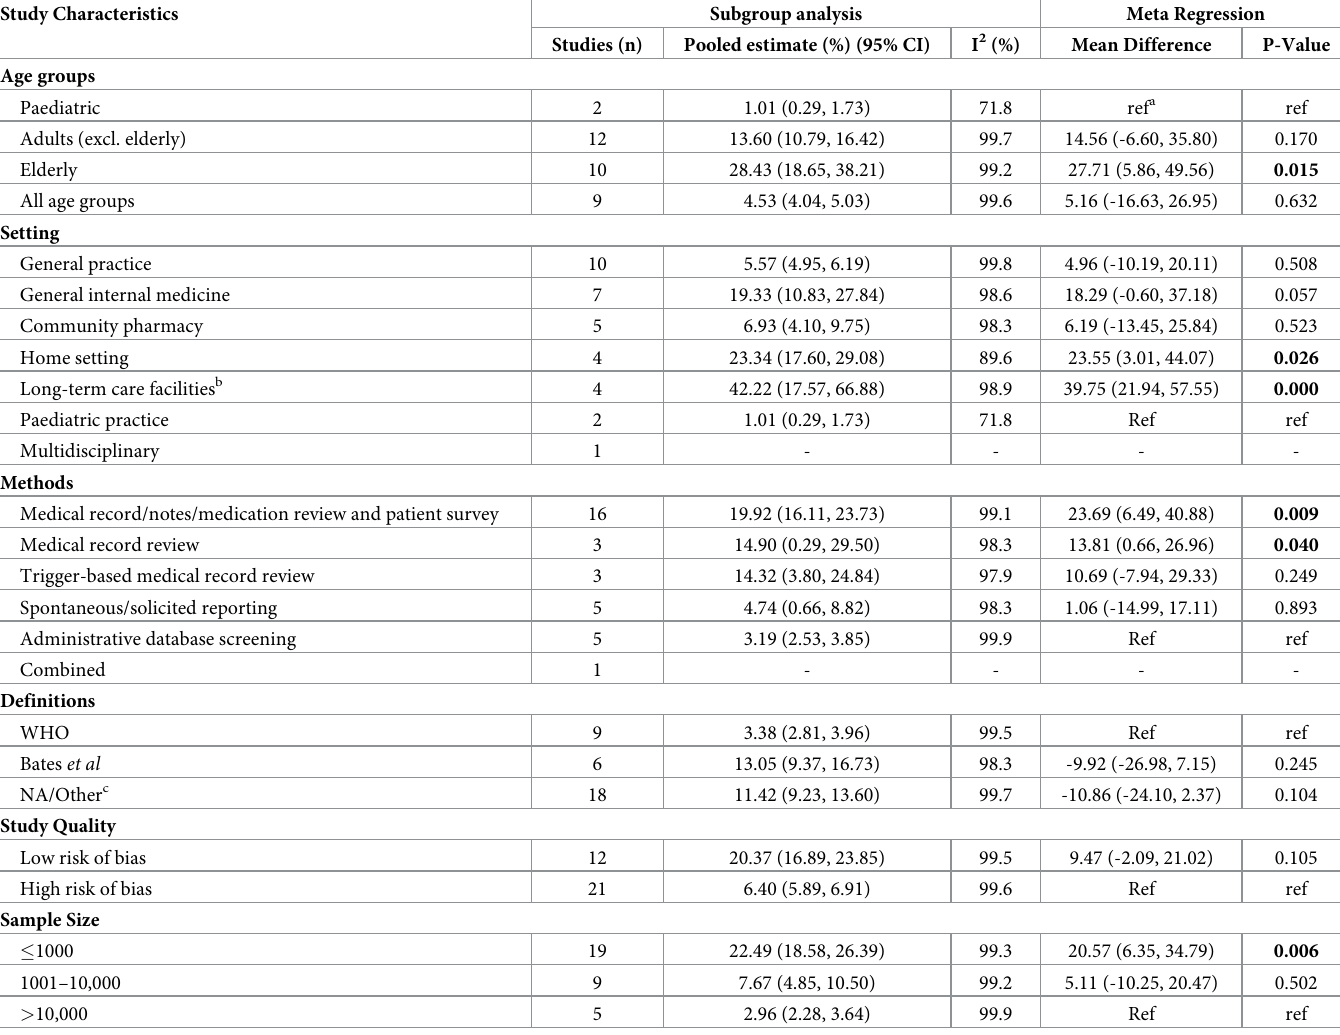
Table 3. Subgroup analysis of included